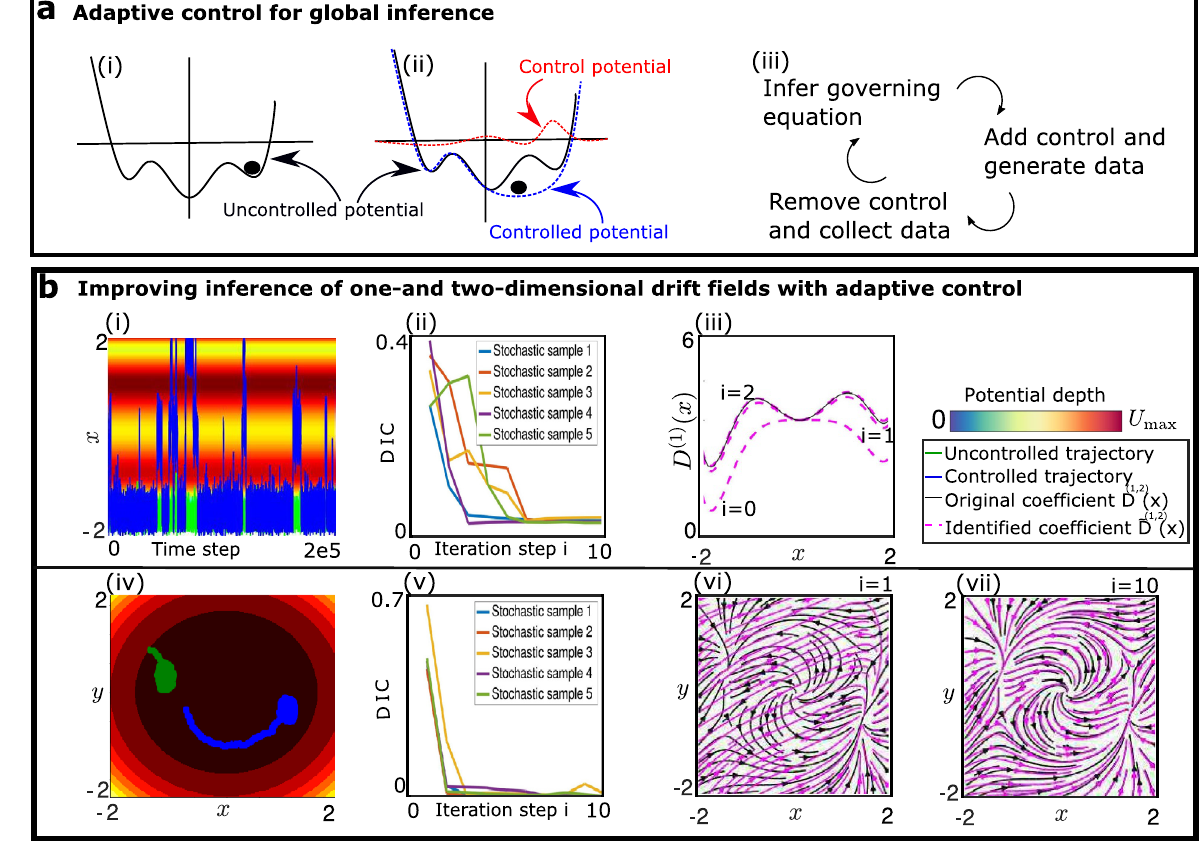
Figure 3. Active learning with automatic iterative sampling optimization (AISO). ( a ) Schematic presentation of automatic iterative sampling optimization for the case of Brownian diffusion ( a-i ). Initially, the particle is trapped in a local energetic minimum and the functional form of the potential can therefore only be inferred locally. ( a-ii ) After the first iteration step, the potential hypersurface near the estimated minimum is flattened and the particle can thus explore other regions of phase space. The same procedure is repeated iteratively and the control is always applied at the minimum estimated during the previous iteration. ( a-iii ) Schematic representation of the main feedback control loop. ( b-i ) Trajectory of a particle undergoing Brownian motion in a one-dimensional three-well potential. The green curve shows a trapped trajectory while the blue curve shows a trajectory in the presence of control forces. ( b-ii ) The deviation of the inferred coefficients (DIC) decreases during the iterations. ( b-iii ) The identified drift field converges to the correct function during the iteration. (b- iv ) Trajectory of a particle undergoing diffusion in a two-dimensional force field. The green curve exemplifies a trapped trajectory for plain sampling. The blue curve shows an example of a trajectory in the presence of control forces. The color of the background only represents part of the force field, namely a Mexican hat potential ( x 2 ( x 2 V ( x , y ) y 2 )/ 2 y 2 ) 2 / 4 that generates radial forces. ( b-v ) Evolution of the of the DIC during = − + + + the iterations. ( b-vi ) Streamlines of the identified drift field (pink) and streamlines of the correct drift field (black) after the first iteration step. ( b-vii ) Streamlines of identified drift field (pink) and streamlines of the correct drift field (black) after the tenth iteration step. The identified force field at the end of the iteration closely matches the original